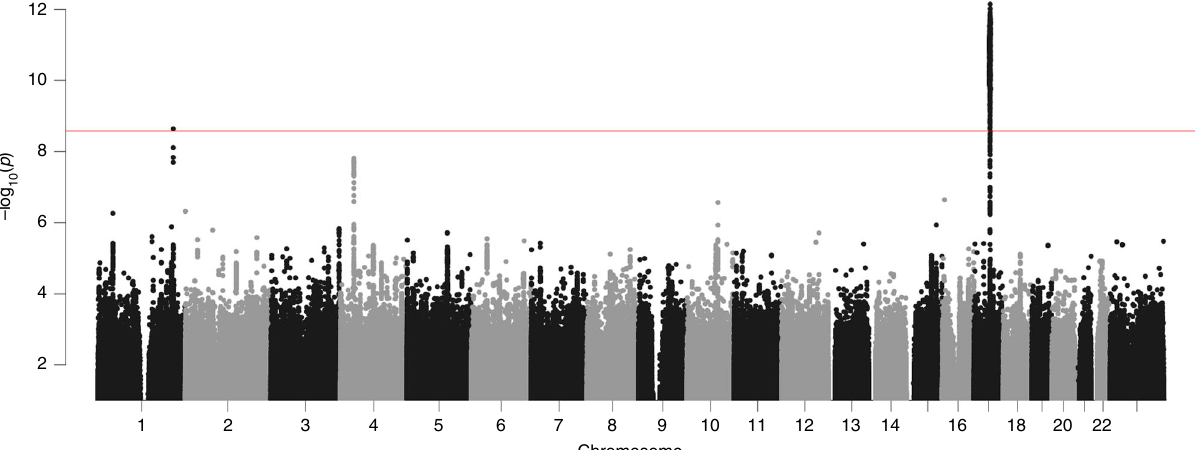
Fig. 2 Manhattan plot of the GWAS results for the UK Biobank data. The horizontal line denotes the P value threshold for genome-wide signi fi